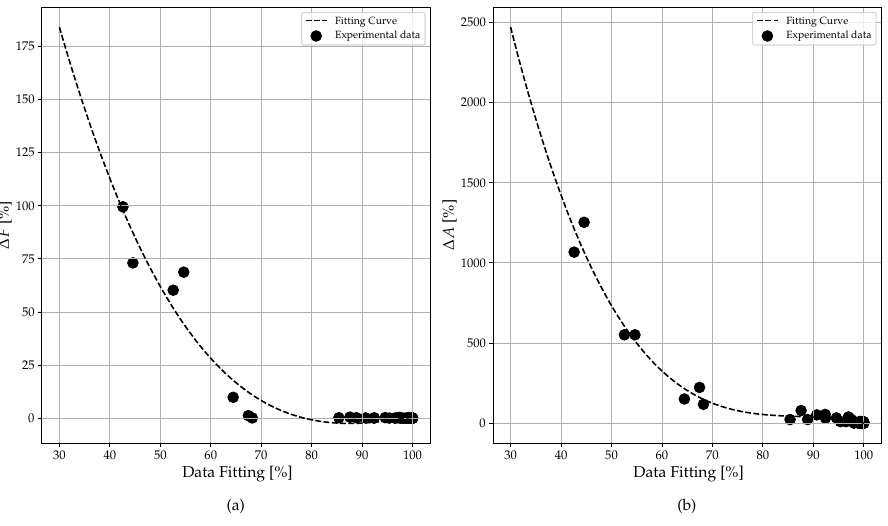
Figure 19. Trends of data fitting against ∆ F ( a ) and data fitting against ∆ A ( b